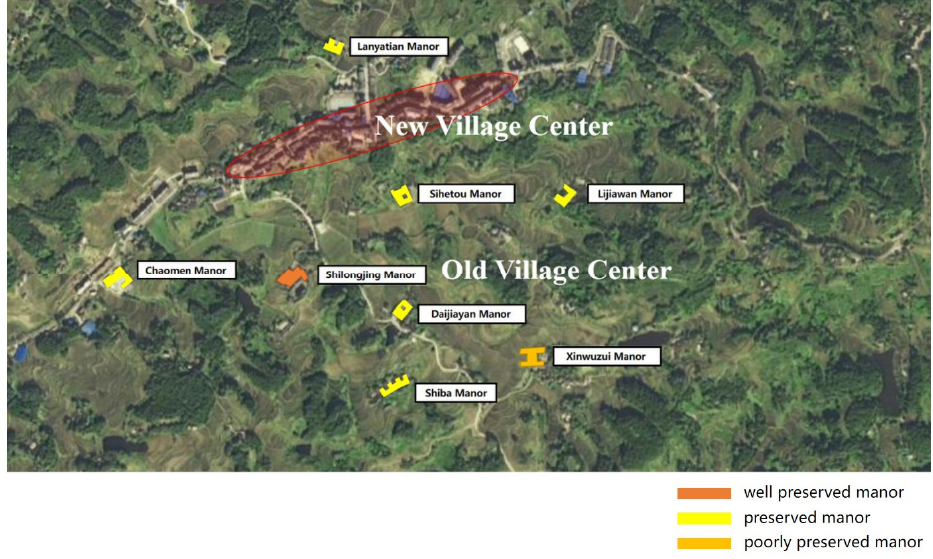
Figure 6. The northward shift of the center of Anzhen Village (source: Drawn by the author).